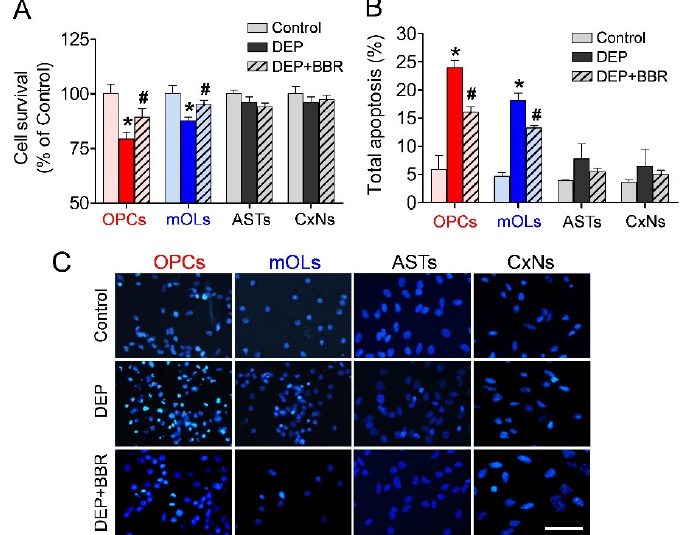
Figure 6. Viability analyses of brain cells after exposure to ultrafine DEP. ( A ) MTT assay. The survival rates of OPCs and mOLs exposed to ultrafine DEPs (200 μg/mL) are significantly decreased compared with those in each control group. BBR treatment inhibits the significant decrease of the survival rates of OPCs and mOLs exposed to ultrafine DEPs. There are no significant changes in the survival rates of astrocytes and cortical neurons compared with that in each control group. ( B ) Annexin V assay. The total proportions of apoptotic OPCs and mOLs are significantly increased compared with those in each control group. BBR treatment inhibits the significant increase of the total proportions of apoptotic OPCs and mOLs exposed to ultrafine DEPs. Although the total proportions of apoptotic astrocytes and cortical neurons are slightly elevated, there are no statistical changes compared with those in each control group. ( C ) Hoechst staining. The number of damaged OPCs and mOLs with condensed or fragmented nuclei after ultrafine DEP exposure (200 μg/mL) are markedly increased compared with that in each control group. However, BBR treatment inhibits the increase of the number of damaged OPCs and mOLs exposed to ultrafine DEPs. Damaged astrocytes and cortical neurons are not observed in the three groups. ASTs = astrocytes, CxNs = cortical neurons. * p < 0.05 for DEP group vs. control, # p < 0.05 for DEP + BBR group vs. DEP group. Scale bar = 200 μm.